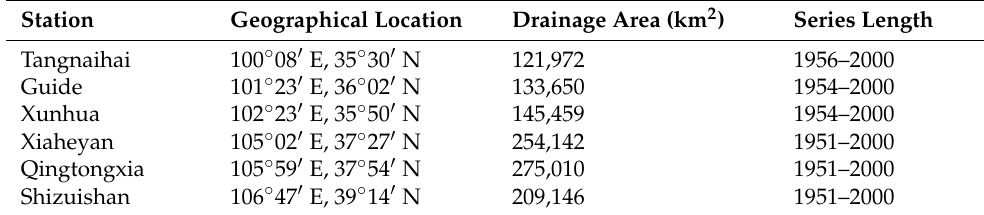
Table 1. Basic information of the hydrological gauging stations.